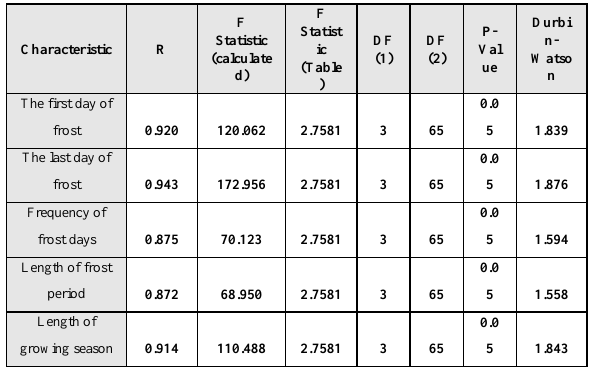
Table 1- the abstract of statistics of regression models for statistical characteristics of frosts in